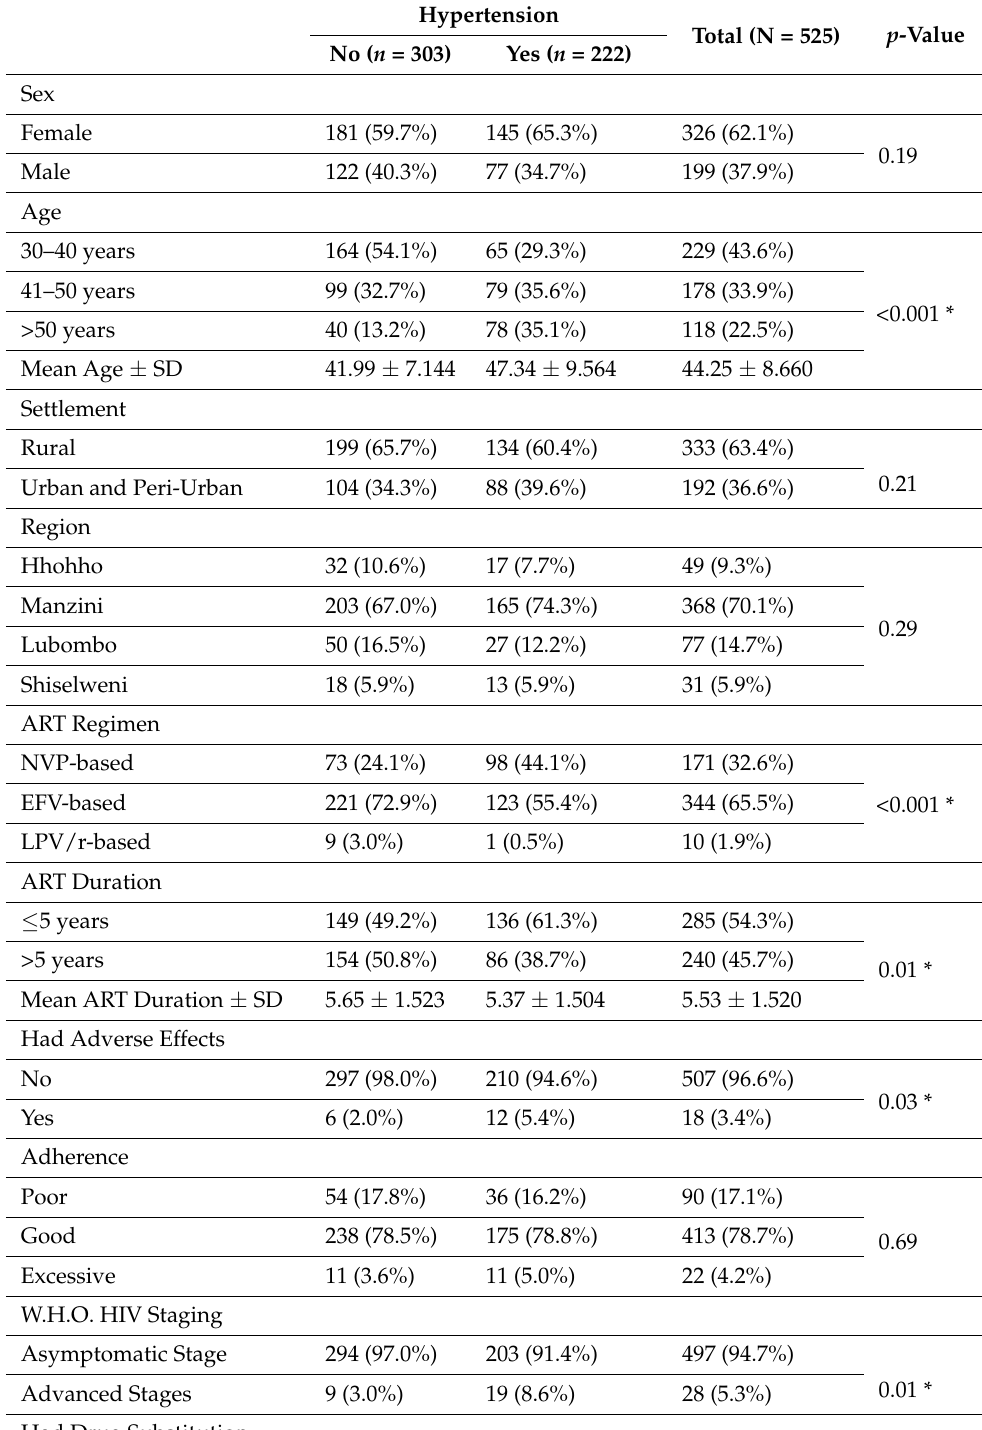
Table 1. Demographic and Clinical Characteristics of